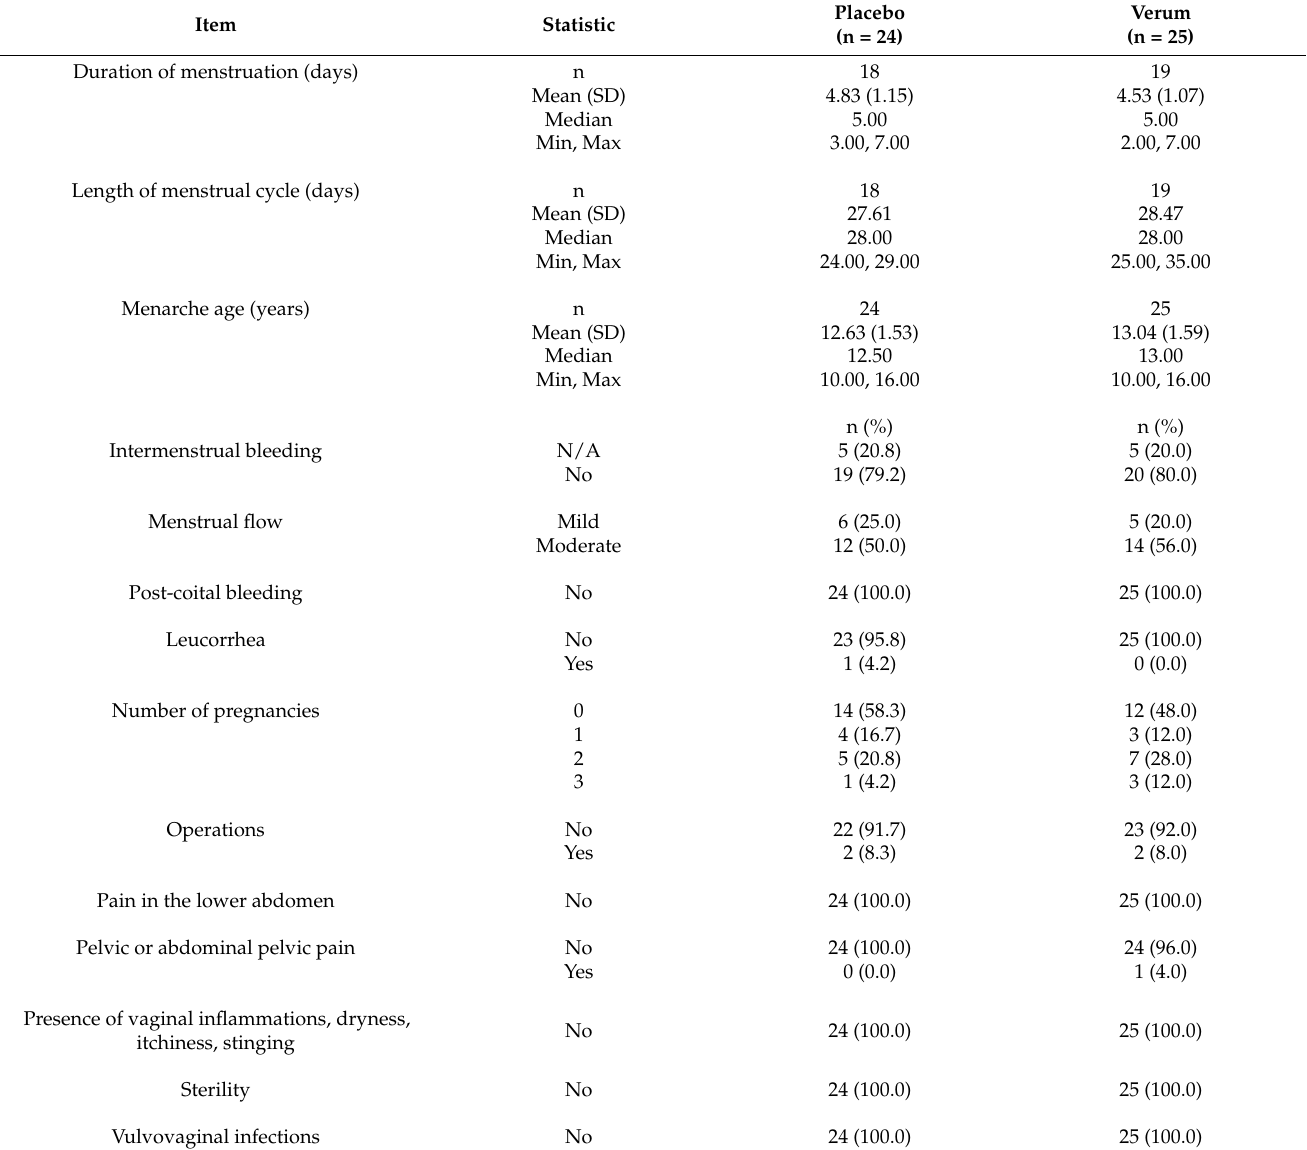
Table 4. Details on menstruation cycle and obstetric history for the intention-to-treat